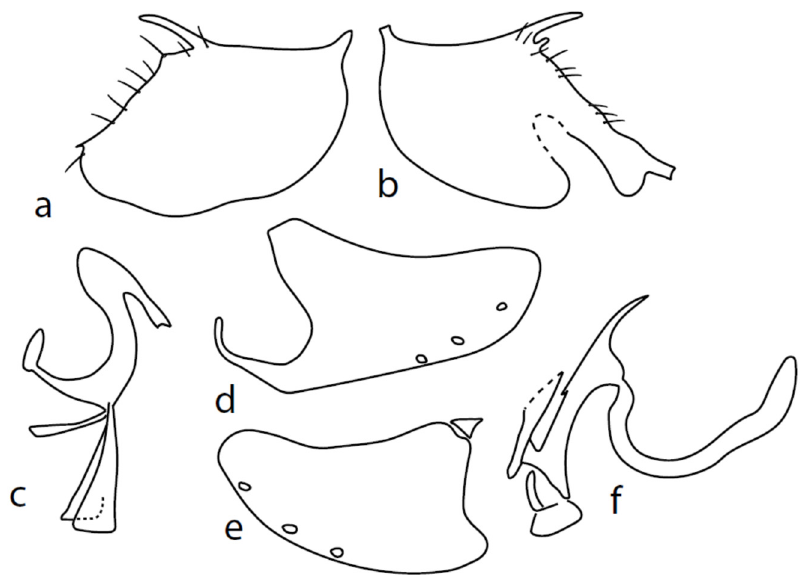
Figure 3. M. chvalai sp. nov.: ( a ) = right epandrial lamella, ( b ) = left epandrial lamella, ( c ) = postgonites from left (left dorsal process without connecting structure, which remained attached to left dorsoapical hypandrial lobe), ( d ) = hypandrium from right, ( e ) = hypandrium from left, ( f ) = phallus from left.